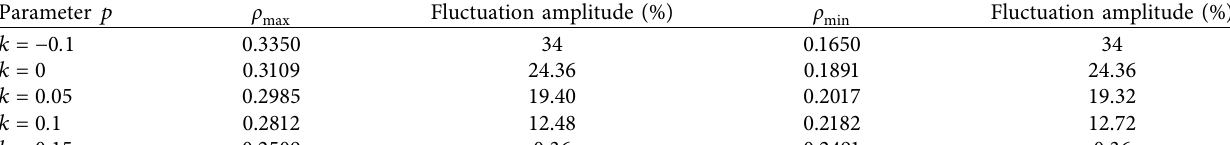
Fluctuation amplitude (%) min